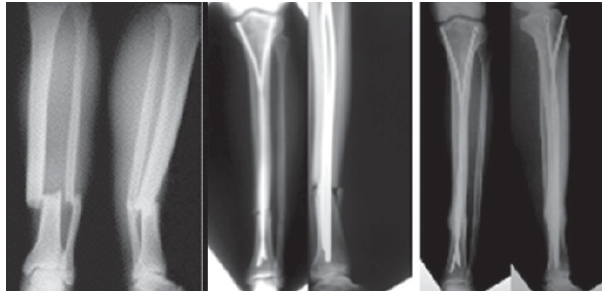
Figure 1 - Appropriate technique for using Ender pins. Proper positioning of the pins provides sufficient stability for union and prevents proximal